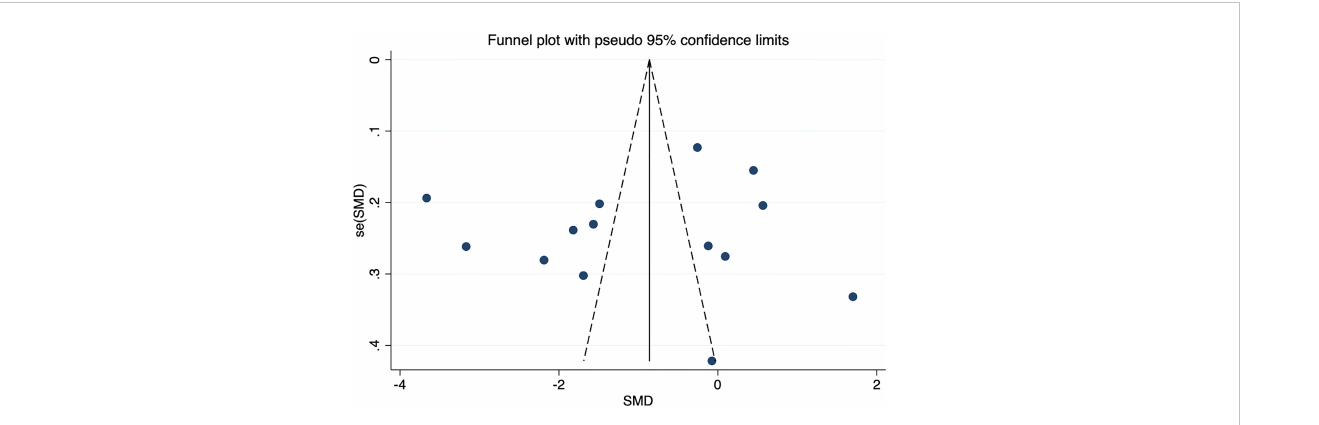
FIGURE 6 Funnel plot of circulating omentin levels between MAFLD and healthy control group. Funnel plot did not indicate a publication